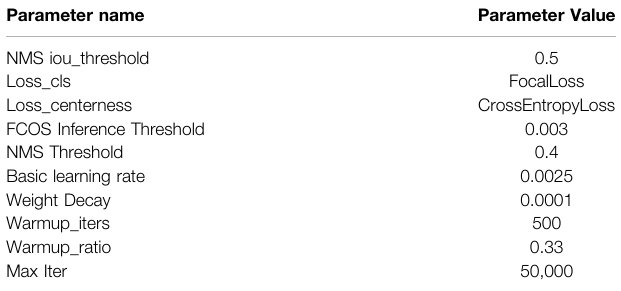
TABLE 2 | The selection of parameter